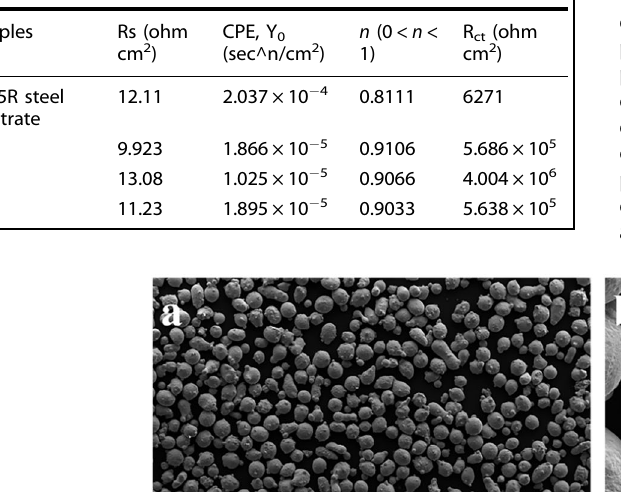
Table 7. The icon means of equivalent electrical circuit curve in Fig. 9d.